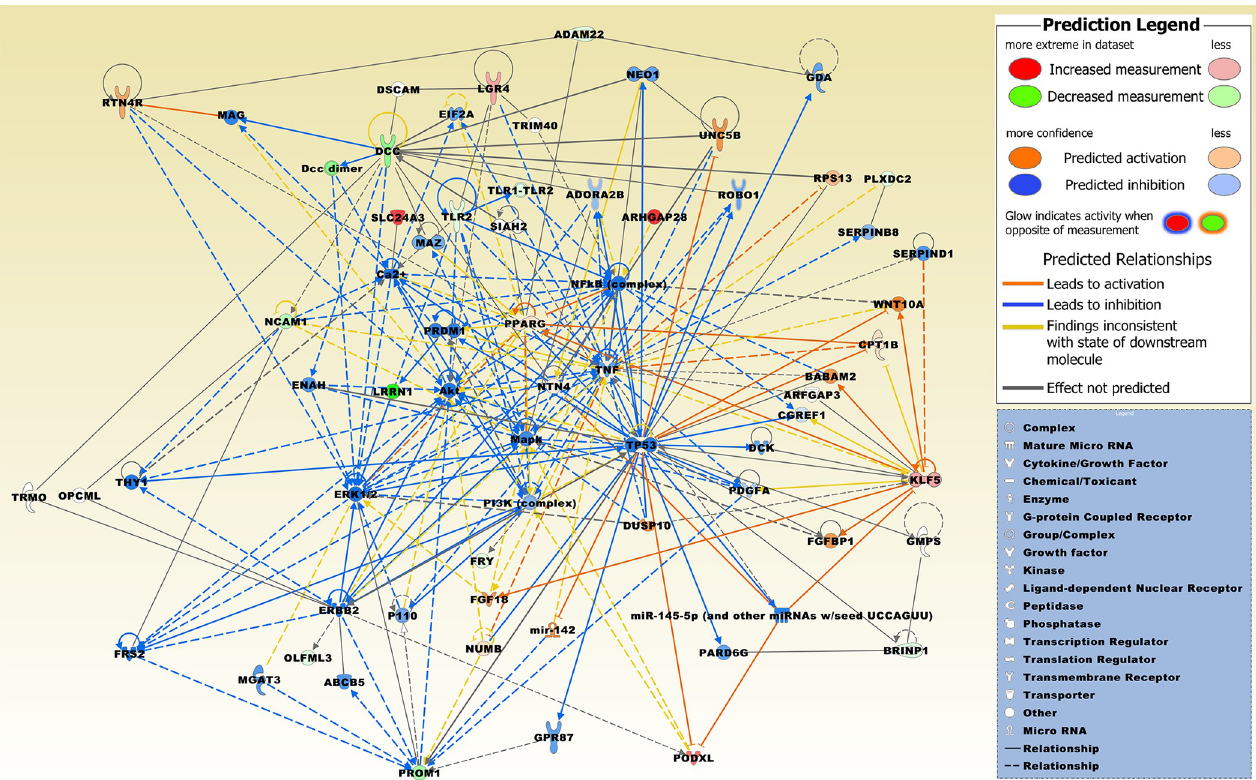
Fig 3. Top two merged networks of genes present in at least three different data sets in the DCC low vs . DCC high expression groups. These genes/ molecules include, besides DCC, ADAM22, ARHGAP28, BRINP1, FRY, KLF5, LGR4, LRRN1, NCAM1, OLFML3, PLXDC2, PODXL, PROM1, SLC24A3, and TLR2. Integrative network molecules comprise, ATP binding cassette subfamily B member 5 (ABCB5), adenosine A2b receptor (ADORA2B), Akt, ADP ribosylation factor GTPase activating protein 3 (ARFGAP3), BRISC and BRCA1 A complex member 2 (BABAM2), Ca2+, cell growth regulator with EF-hand domain 1 (CGREF1), carnitine palmitoyltransferase 1B (CPT1B), Dcc dimer, deoxycytidine kinase (DCK), DS cell adhesion molecule (DSCAM), dual specificity phosphatase 10 (DUSP10), eukaryotic translation initiation factor 2A (EIF2A), ENAH, actin regulator (ENAH), erb-b2 receptor tyrosine kinase 2 (ERBB2), ERK1/2, fibroblast growth factor 18 (FGF18), fibroblast growth factor binding protein 1 (FGFBP1), fibroblast growth factor receptor substrate 2 (FRS2), guanine deaminase (GDA), guanine monophosphate synthase (GMPS), G protein-coupled receptor 87 (GPR87), myelin associated glycoprotein (MAG), Mapk, MYC associated zinc finger protein (MAZ), mannosyl (beta-1,4-)-glycoprotein beta-1,4-N-acetylglucosaminyltransferase (MGAT3), microRNA 142 (mir-142), miR-145-5p (and other miRNAs with seed UCCAGUU), neogenin 1 (NEO1), NFkB (complex), netrin 4 (NTN4), NUMB, endocytic adaptor protein (NUMB), opioid binding protein/cell adhesion molecule like (OPCML), P110, par-6 family cell polarity regulator gamma (PARD6G), platelet derived growth factor subunit A (PDGFA), PI3K (complex), peroxisome proliferator activated receptor gamma (PPARG), PR/SET domain 1 (PRDM1), roundabout guidance receptor 1 (ROBO1), ribosomal protein S13 (RPS13), reticulon 4 receptor (RTN4R), serpin family B member 8 (SERPINB8), serpin family D member 1 (SERPIND1), siah E3 ubiquitin protein ligase 2 (SIAH2), Thy-1 cell surface antigen (THY1), TLR1-TLR2, tumor necrosis factor (TNF), tumor protein p53 (TP53), tripartite motif containing 40 (TRIM40), tRNA methyltransferase O (TRMO), unc-5 netrin receptor B (UNC5B), and Wnt family member 10A (WNT10A). S3 Table contains the relationships of